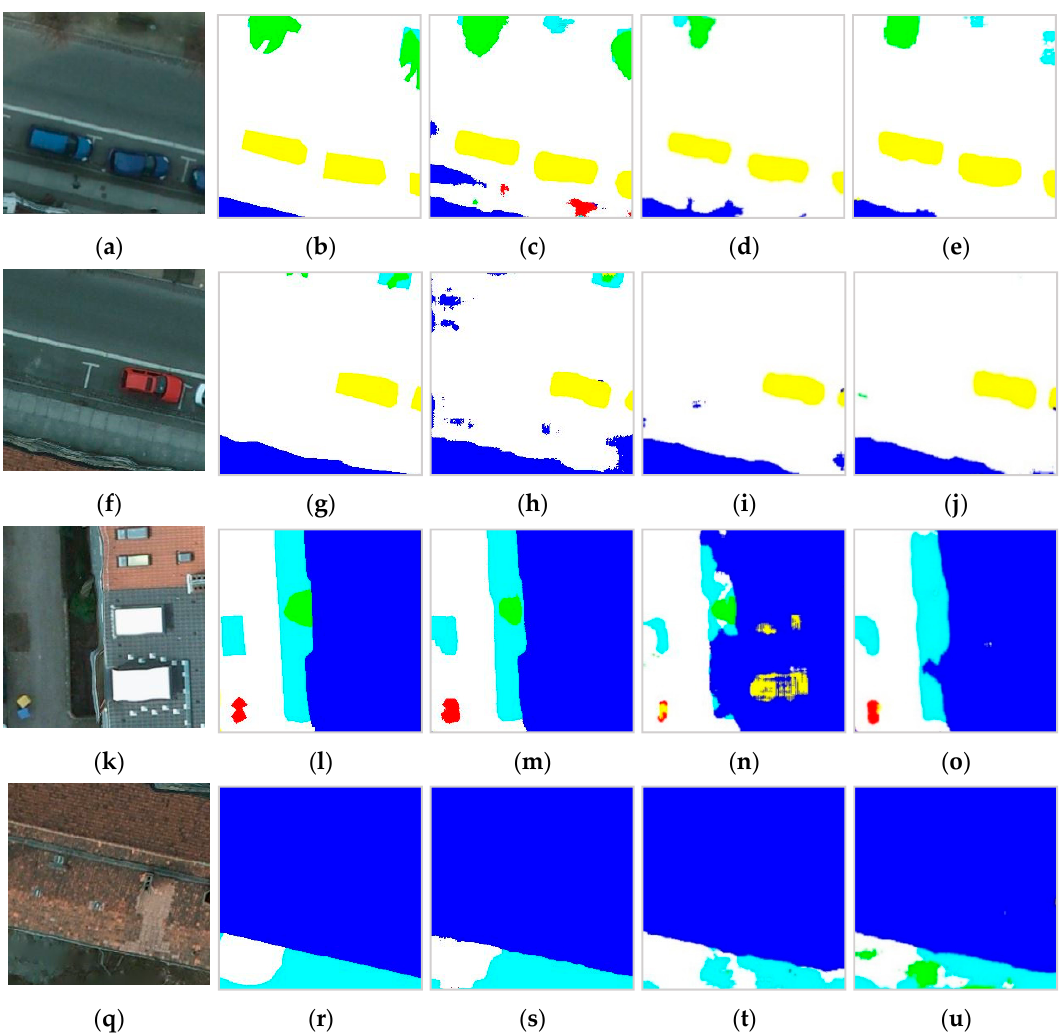
Figure 7. Example of input Potsdam RGB, label, and the resulting semantic segmentation images for the three cases. ( a , f , k , q ) are the input Potsdam images, ( b , g , l , r ) are the label images, ( c , h , m , s ) are the resulting images generated in simplified U-net, ( d , i , n , t ) are the resulting images generated in Case 1, and ( e , j , o , u ) are the resulting images generated in Case 2.